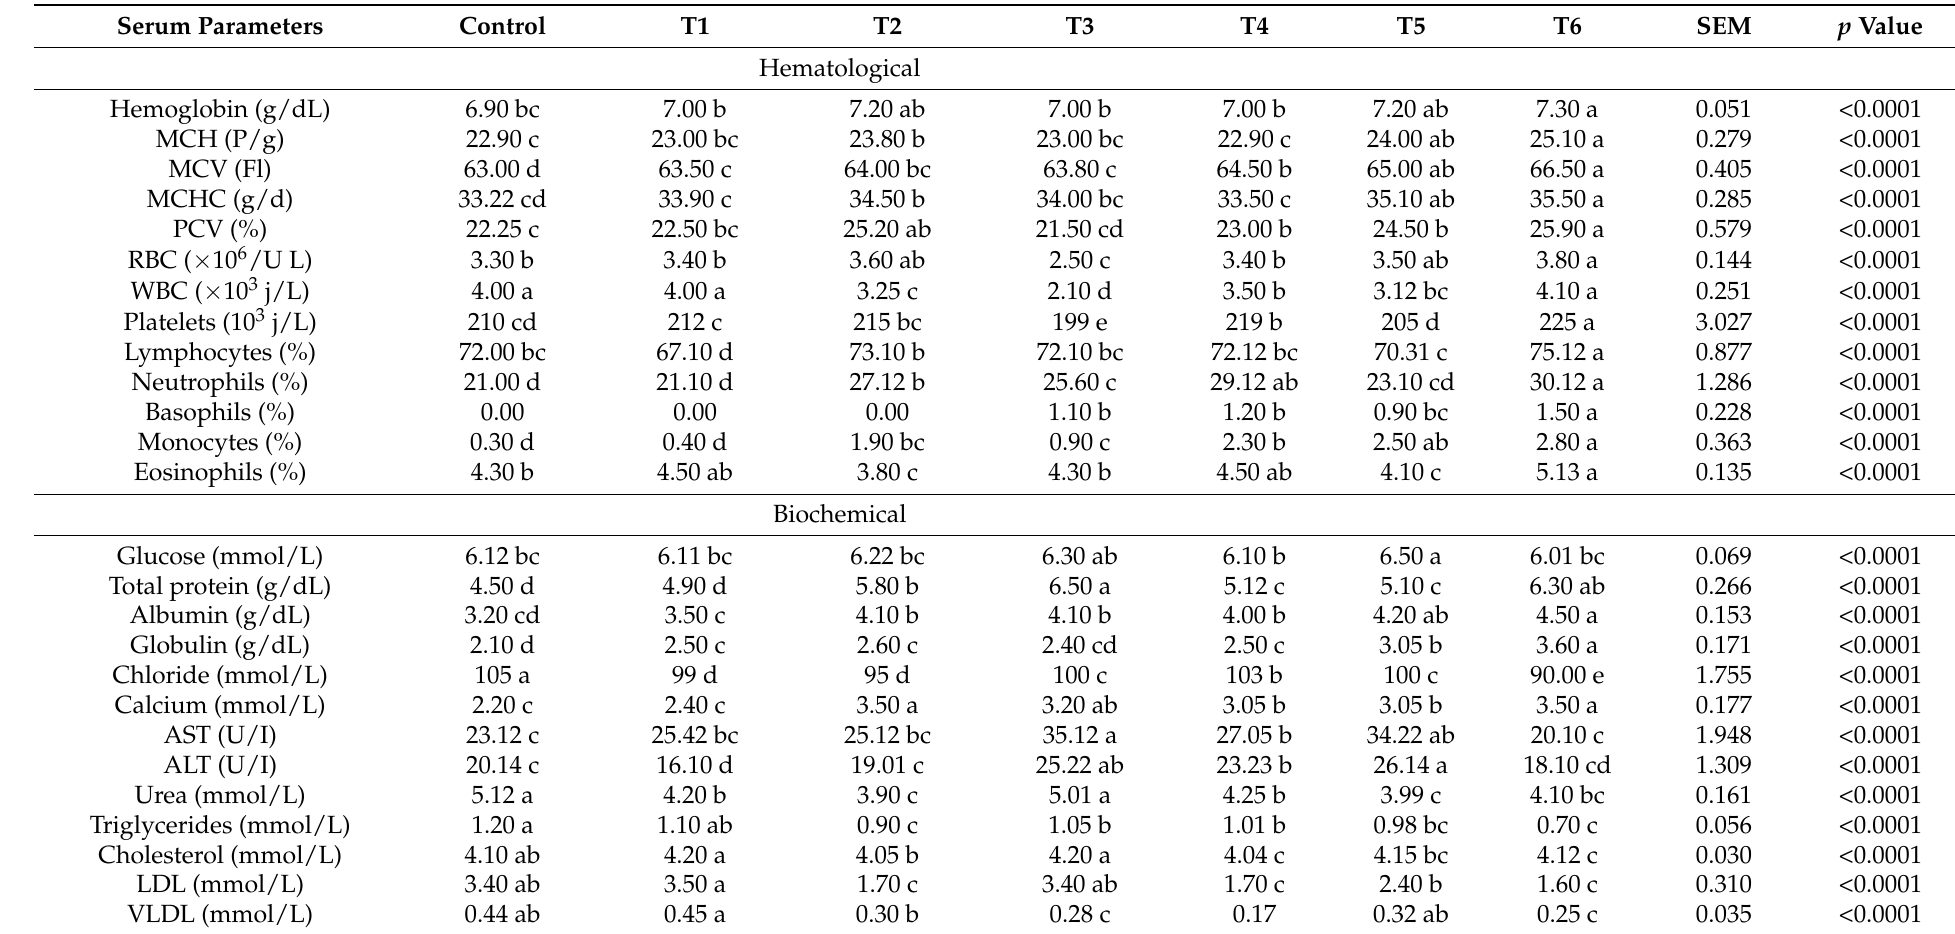
Table 5. Blood hematology, biochemical parameters, serum antioxidants, duodenal enzymes and immunity of broilers as affected by dietary supplementation of ZnNPs, CurNPs, and Bacillus licheniformis . ( n =